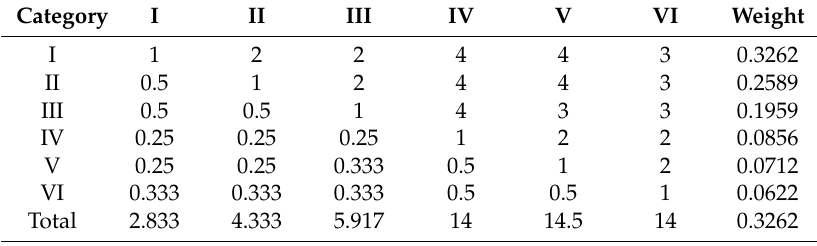
Table 4. Matrix construction and weighting calculation for categories associated with the failure risk assessment.